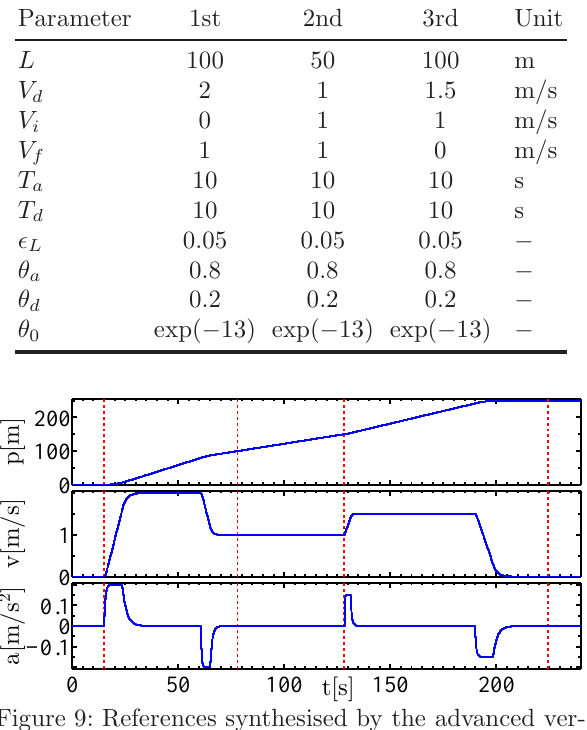
Table 3: Tuning parameters of the RM Parameter